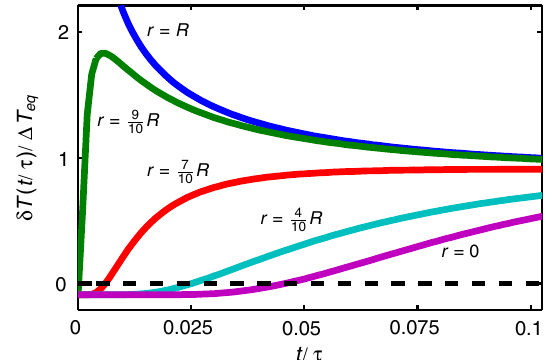
FIG. 3. The temperature of the sphere as a function of time for different radii normalized to the final temperature (cid:1) T Þ . After the addition of heat at the surface, the (cid:5)Q = ð V c p 0 0 temperature drops instantaneously throughout the sphere, show- ing adiabatic cooling. The time scale is given by the character- =(cid:8) . The longitudinal coupling istic heat-diffusion time, (cid:1) ¼ R 2 c l ¼ 0 : 091 . constant is chosen to be a l